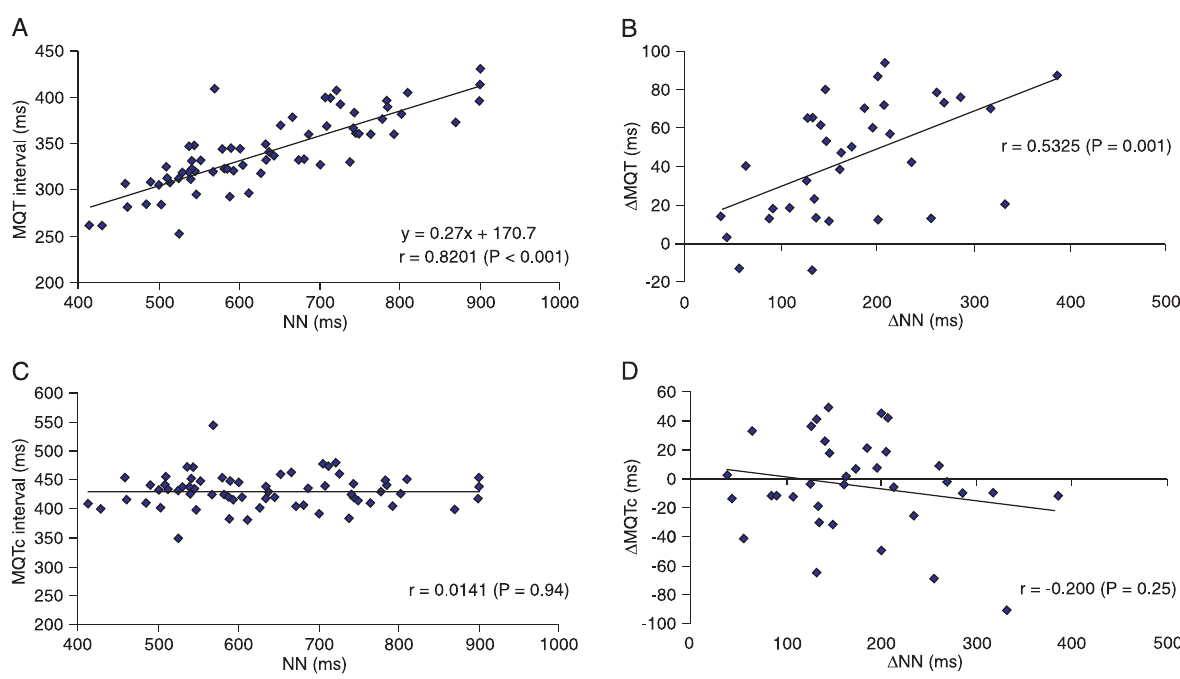
Figure 3. A , Hourly averaged QT intervals (MQT) vs averaged RR intervals (NN). B , Maximal circadian hourly averaged QT interval variation (∆MQT) vs maximal circadian RR interval variation (∆NN). Note the significant Pearson positive correlation. C , Hourly av- eraged corrected-QT intervals (MQTc) vs averaged RR intervals (NN). D , Maximal circadian hourly averaged corrected QT interval variation (∆MQTc) vs maximal circadian RR interval variation (∆NN). Note in the graphs that, after correction, both MQTc and ∆MQTc became independent of NN and ∆NN, respectively.